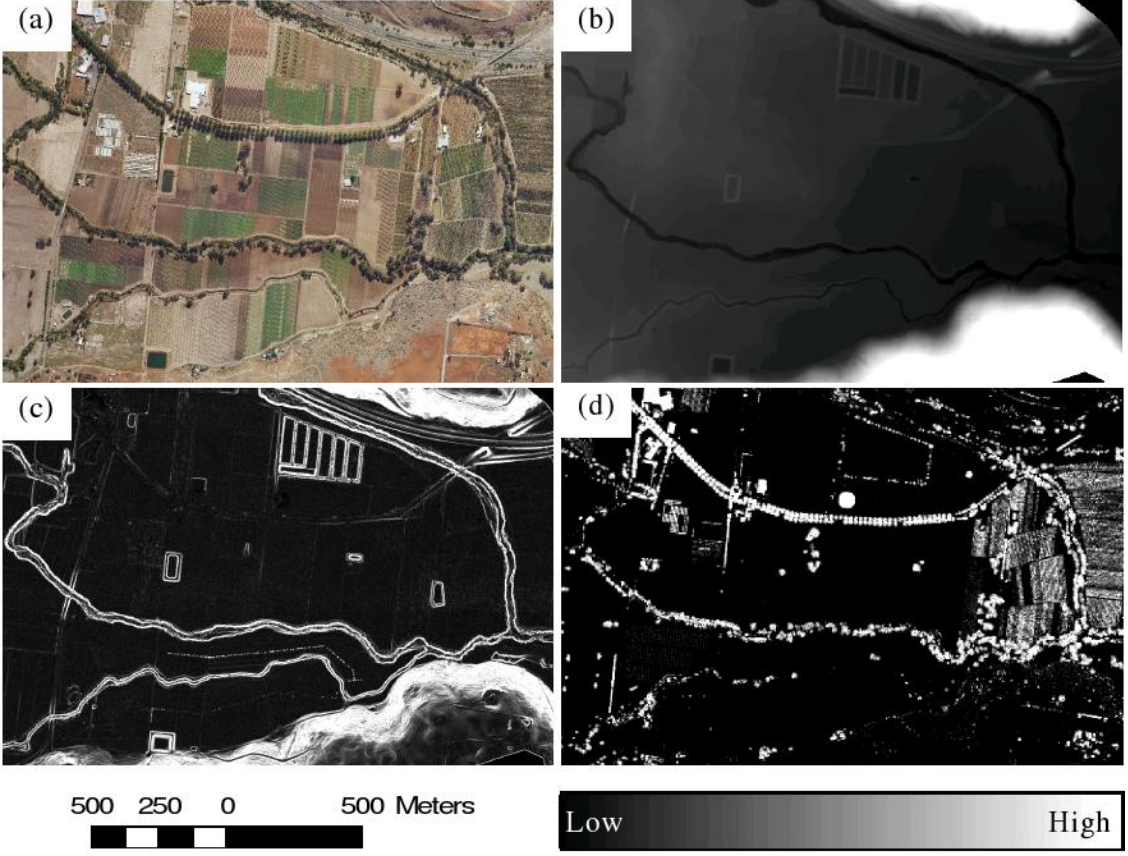
Figure 2. Optical UltracamD image (a) showing part of the study area as a true color composite and corresponding LiDAR derived raster products, including: (b) DTM; (c) slope; and (d) PPC. Bright areas indicate high values and dark areas indicate low